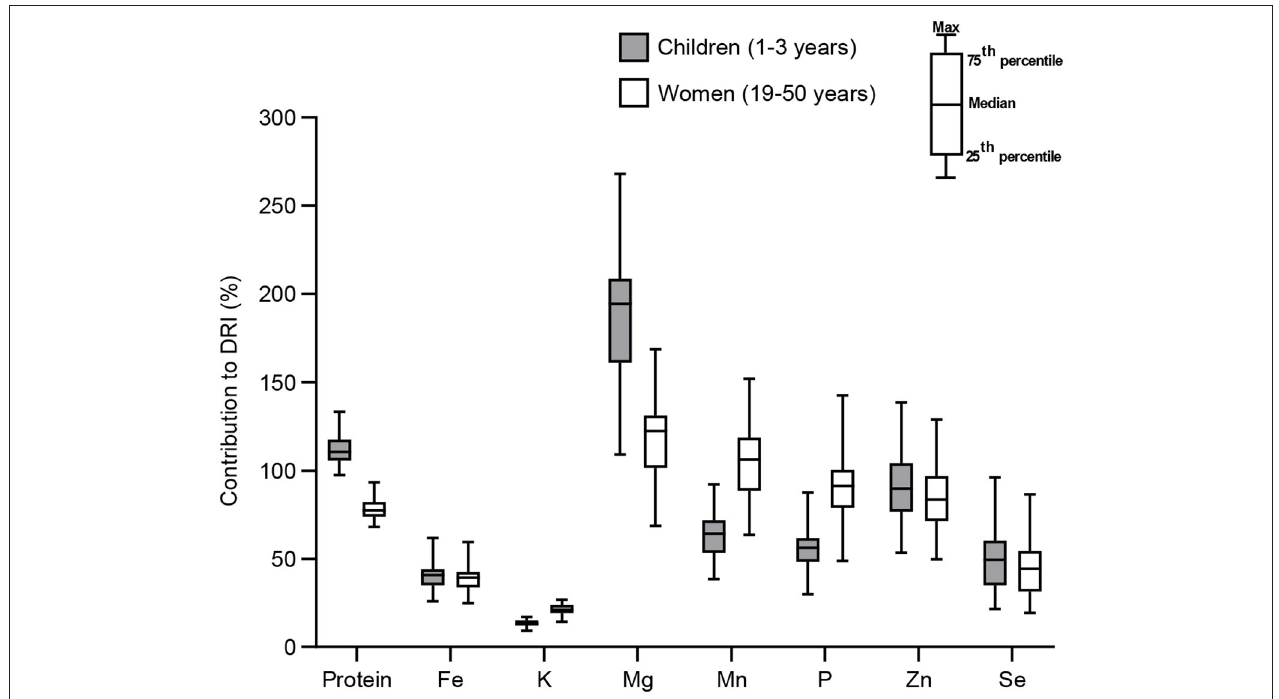
FIGURE 8 | Contribution of maize varieties grown in Malawi to the nutrient dietary requirements of Malawian children and